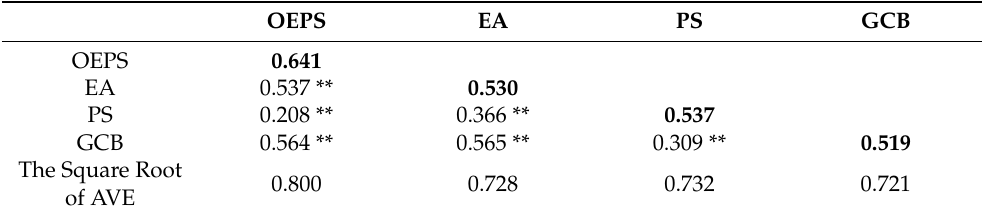
Table 4. The AVE square root of variables and correlation coefficient